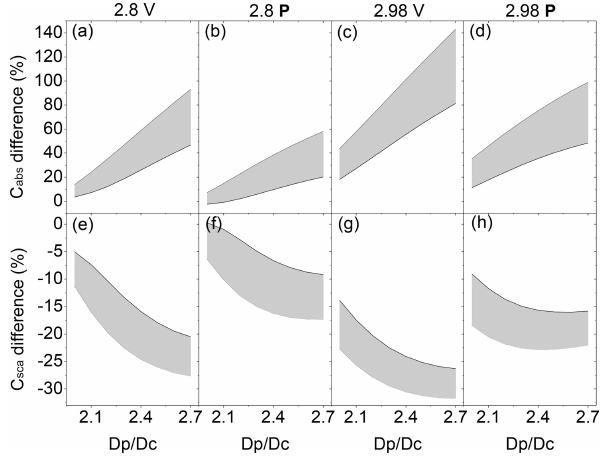
Figure 7. Comparisons between the relative differences of scatter- ing and absorption coefficients of coarse coated black carbon ag- gregates induced by the refractive indices based on the volume- weighted average method ( a , c , e , g ) and those given by the pa- rameterized method described by Eqs. (7) and (8) in the main text ( b , d , f , h ). Two BC fractal dimensions of 2.8 ( a , b , e and f ) and 2.98 ( c , d , g and h ) are considered, and the induced differences for absorption and scattering cross sections are shown in (a)–(d) and (e)–(h) , respectively. The solid lines indicate the cases of core-shell structures with the BC mass center located in the particle geometric center, while the gray areas denote the cases of all possible core- shell structures with BC aggregates inside the sulfate